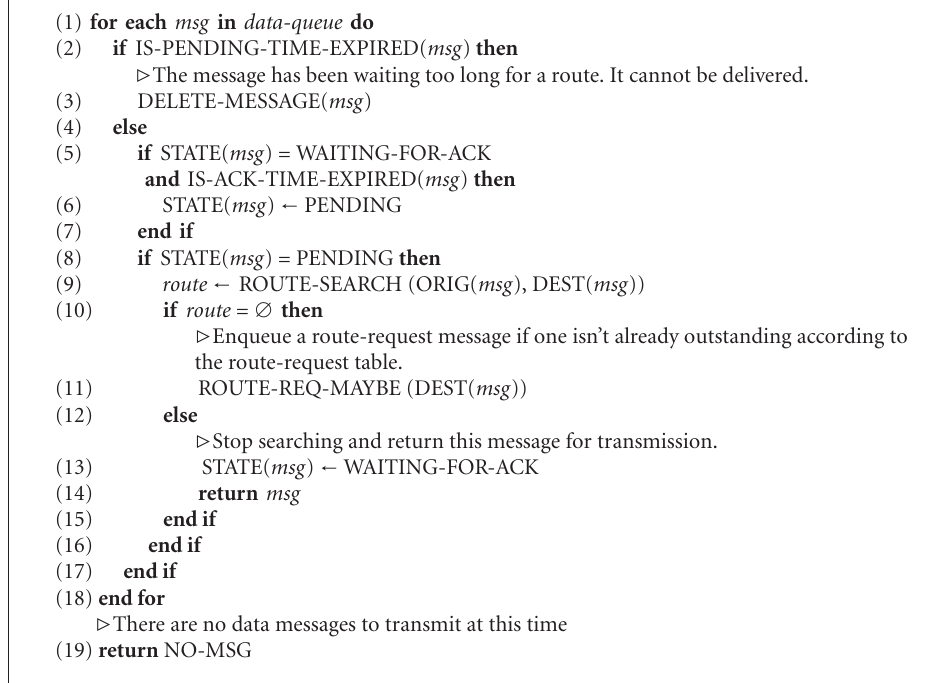
fields contain the distance in meters between the endpoints of the link, as estimated at the time of the